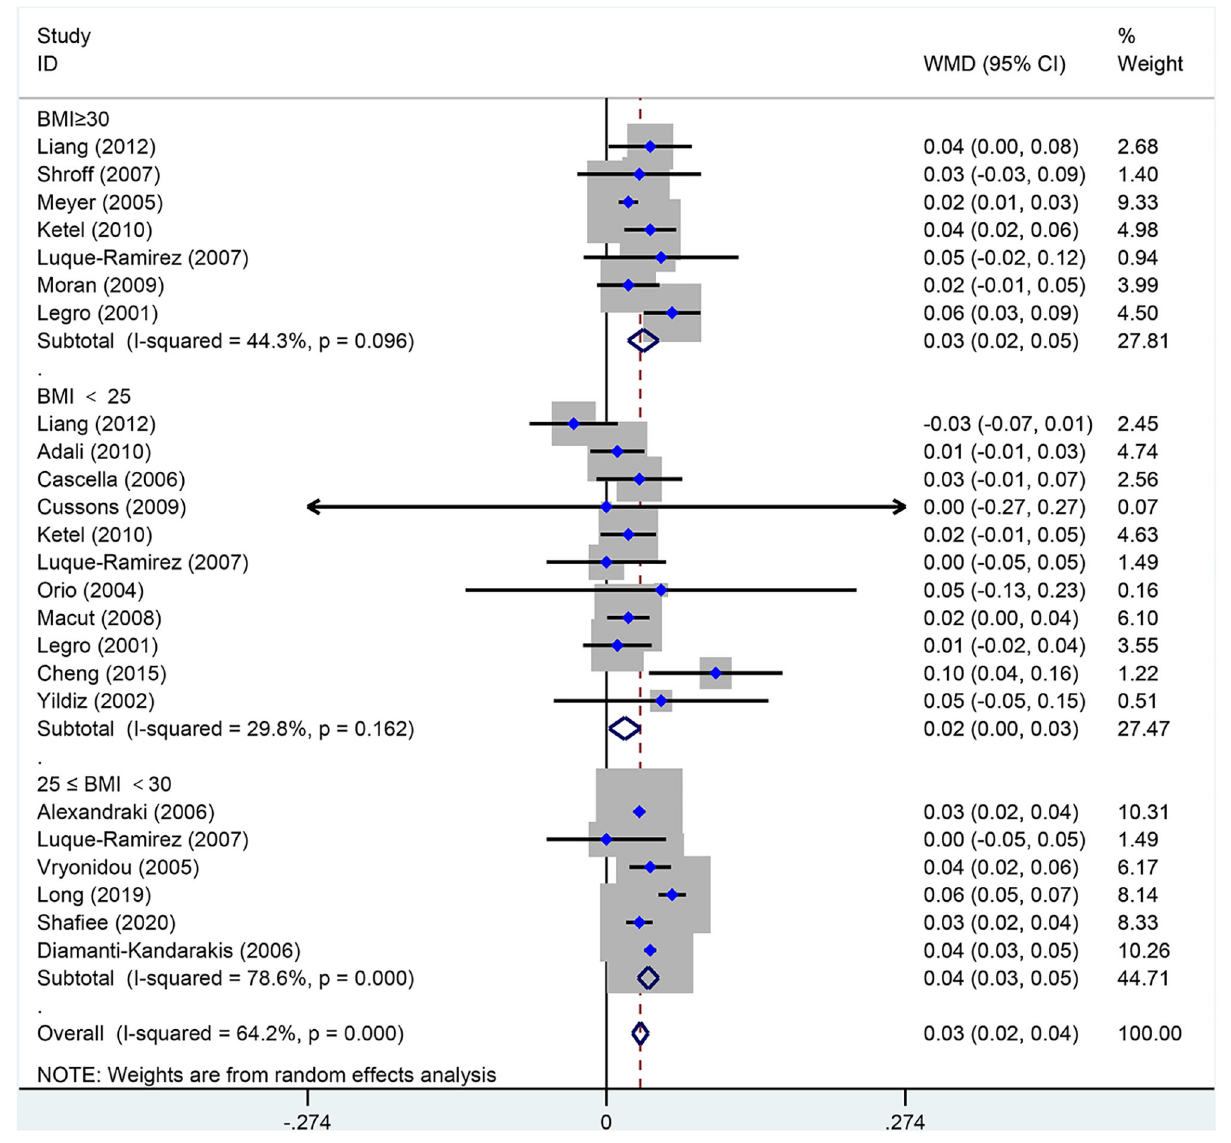
FIGURE 8 | Forest plot for comparison of waist-to-hip ratio in polycystic ovary syndrome vs. control subjects. Studies are classified by different body mass index (BMI) categories (BMI < 25 kg/m 2 , BMI ≥ 30 kg/m 2 , and BMI 25 < 30 kg/m 2